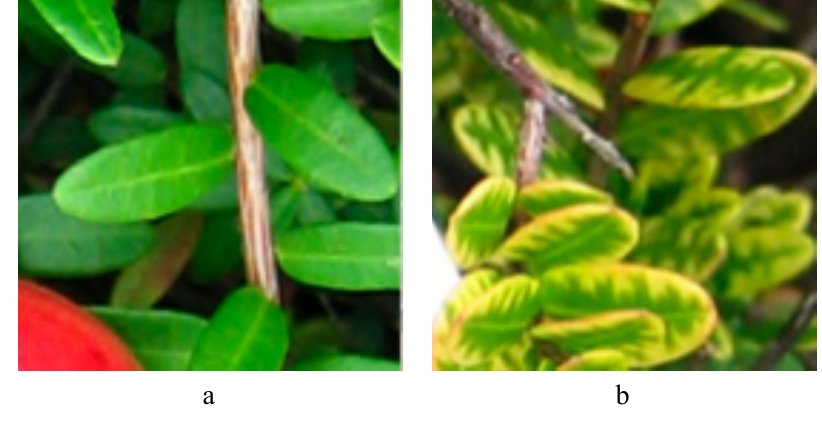
Figure 1. Images of normal cranberry leaves ( a ) and yellow vine syndrome cranberry leaves ( b